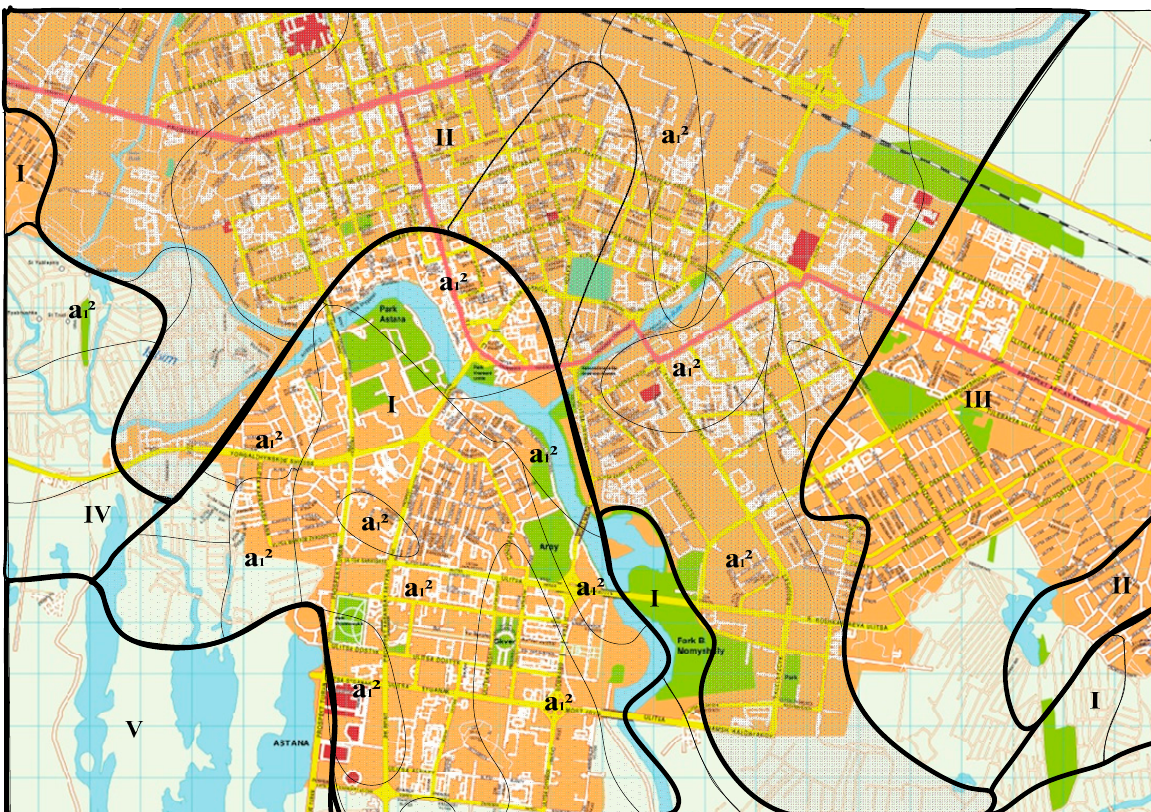
Figure 1. Main landforms of Nur-Sultan city by V. Popov [23].